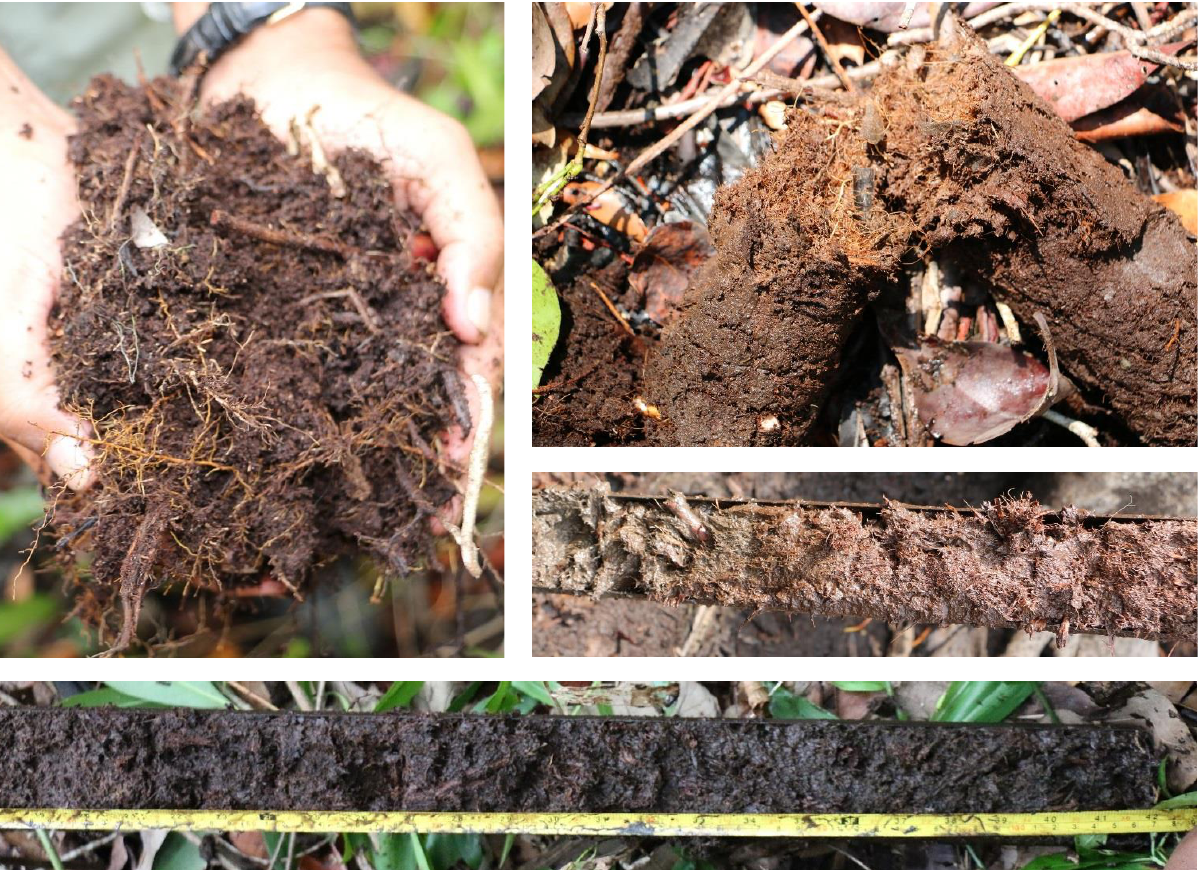
Figure 2: Peat samples from the survey, showing: partially decomposed plant residues mixed with roots (top left); networks of uniform fine roots (top right); organic material mixed with clay (middle right); and dark greyish plant residues